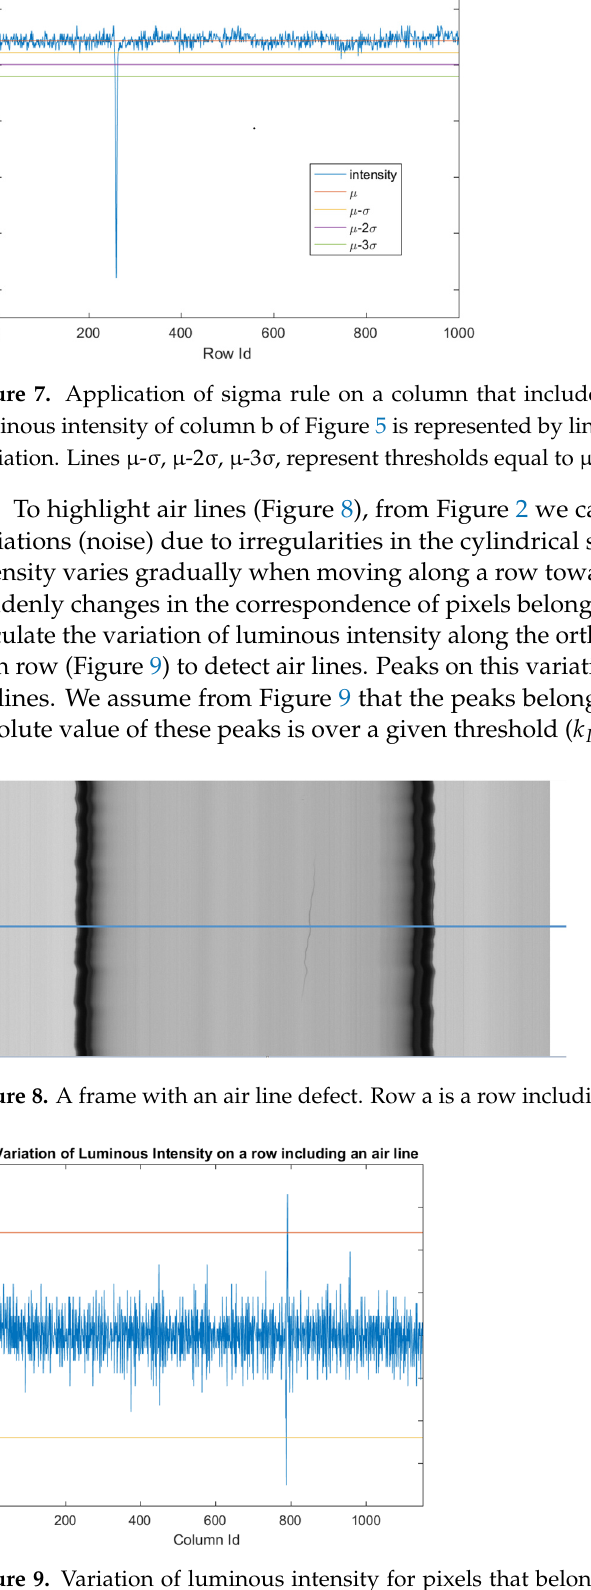
Figure 7. Application of sigma rule on a column that includes a blob defect. The mean of the luminous intensity of column b of Figure 5 is represented by line μ , while σ is the related standard deviation. Lines μ - σ , μ -2 σ , μ -3 σ , represent thresholds equal to μ minus 1, 2, 3 times σ ( 𝑘 (cid:3004) ).